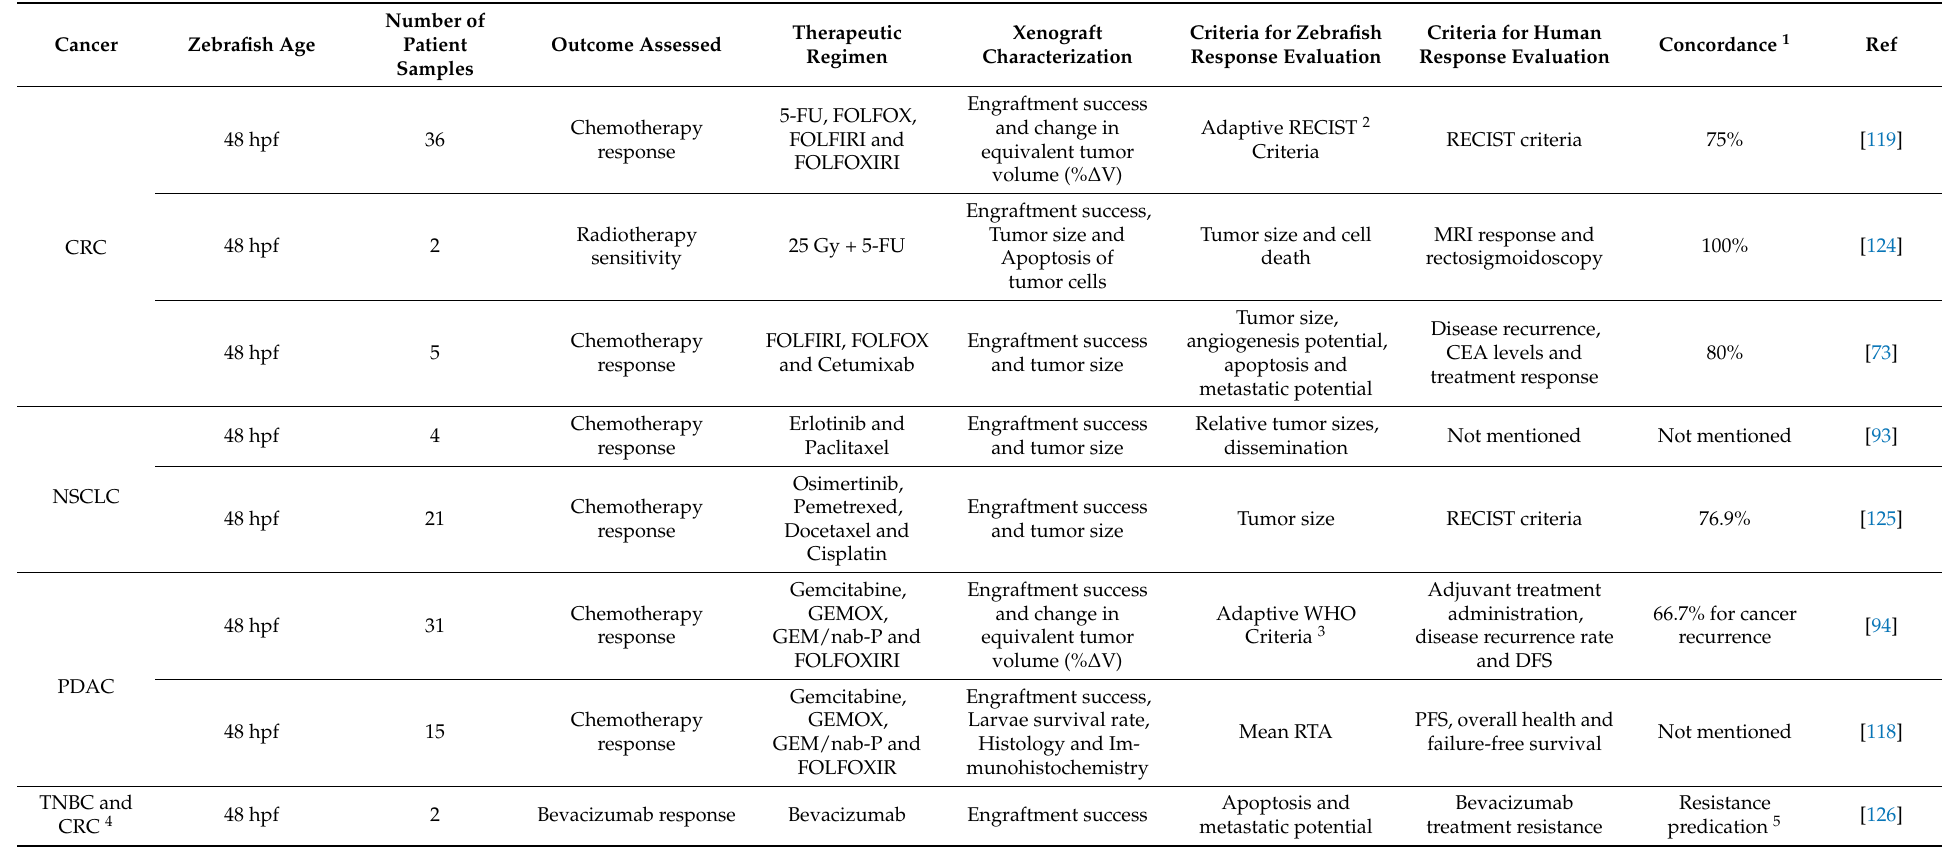
Table 3. Studies correlating zebrafish PDX outcomes to patient outcomes in different